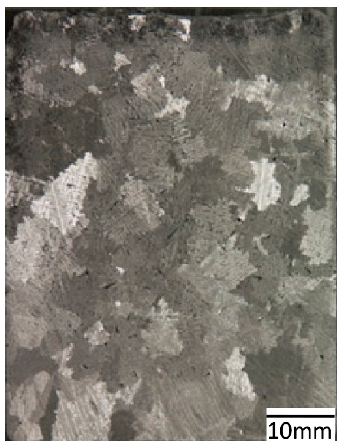
Table 1. Influence of the applied pulsed electric currents (ECP) and traveling magnetic field (TMF) on the grain size.